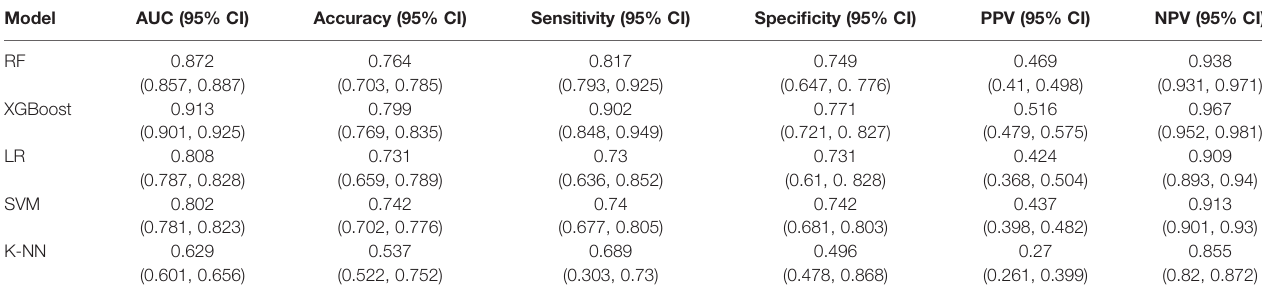
TABLE 1 | The performance metrics of the cross-validated machine learning algorithms on the test data.